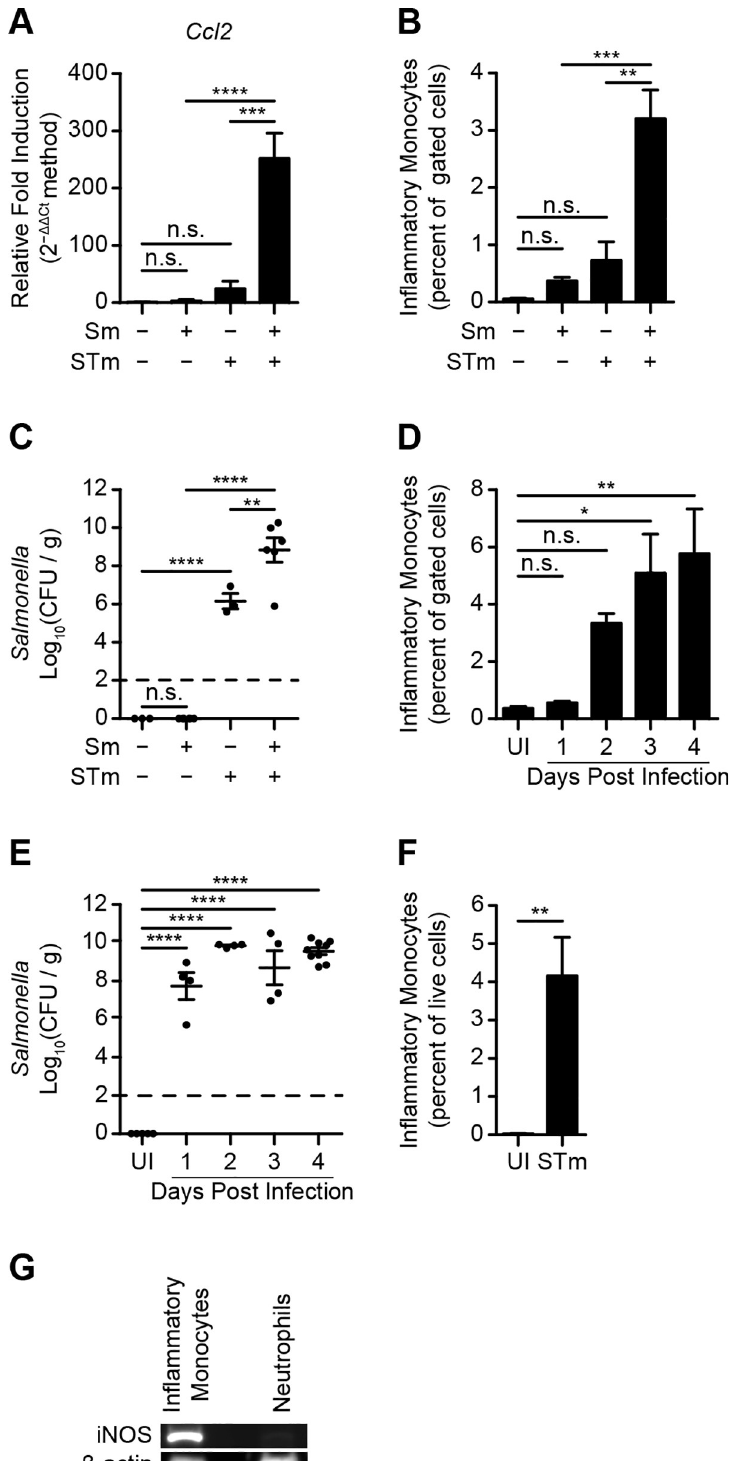
Fig 1. iNOS-producing IM infiltrate ceca of mice infected with STm. (A-C) Effects of Sm pretreatment and STm infection on C57BL/6J mice (n = 3–7 per group). Samples were harvested on day 4 after infection. Data show mean with SEM (A and B) or mean with SEM and individual data points (C), and were analyzed by one-way ANOVA with Sidak post hoc test. (A) Relative fold induction of Ccl2 expression in cecal tissues, normalized to Gapdh . (B) Percentage